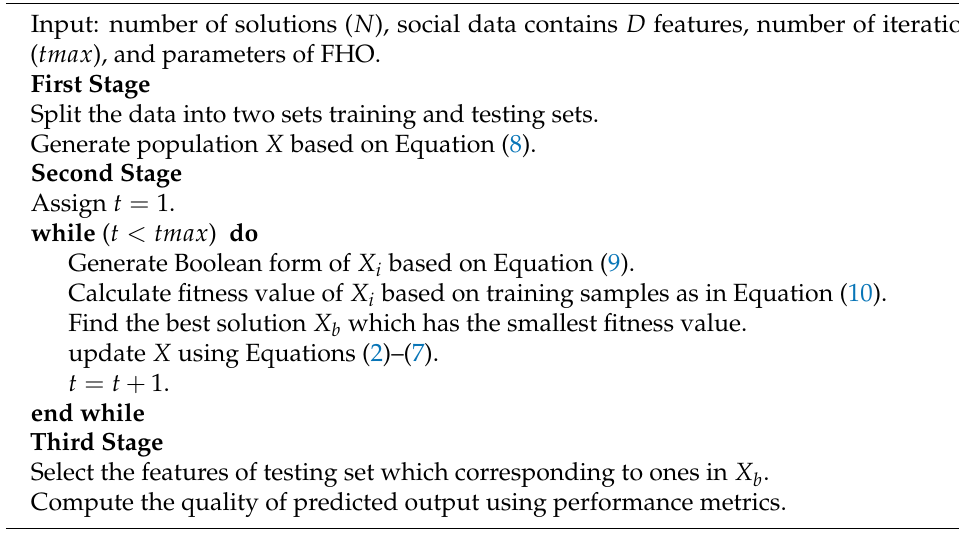
Algorithm 2 The FS based on the BFHO